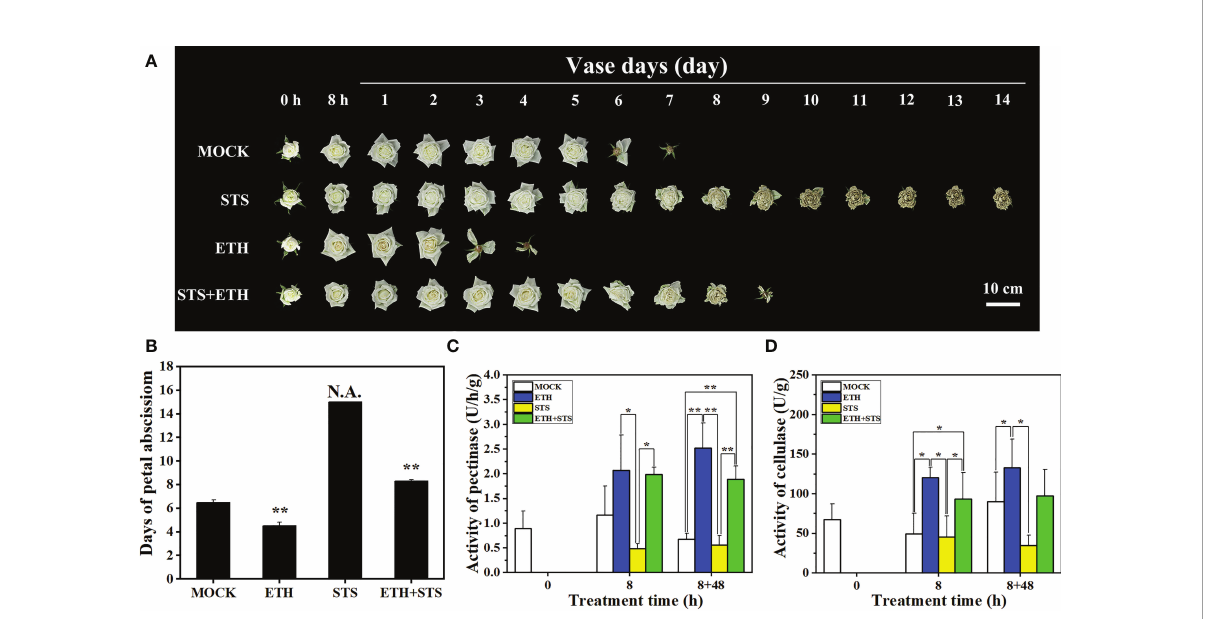
FIGURE 1 Analysis of phenotype, abscission time and enzyme activity in petal abscission process of rose. (A, B) Abscission phenotype and abscission time of rose petals under different treatments. 0 h, untreatment; 8 h, 8 h in treatment of different solutions; 1 to 14 days, days after treatment; N.A., no abscission. Scale bars 10 cm. (C, D) Changes of pectinase and cellulase activities in rose AZ. Statistical signi fi cance between different treatment and control groups was tested using Duncan ’ s test (*p < 0.05; **p < 0.01), biological replicates